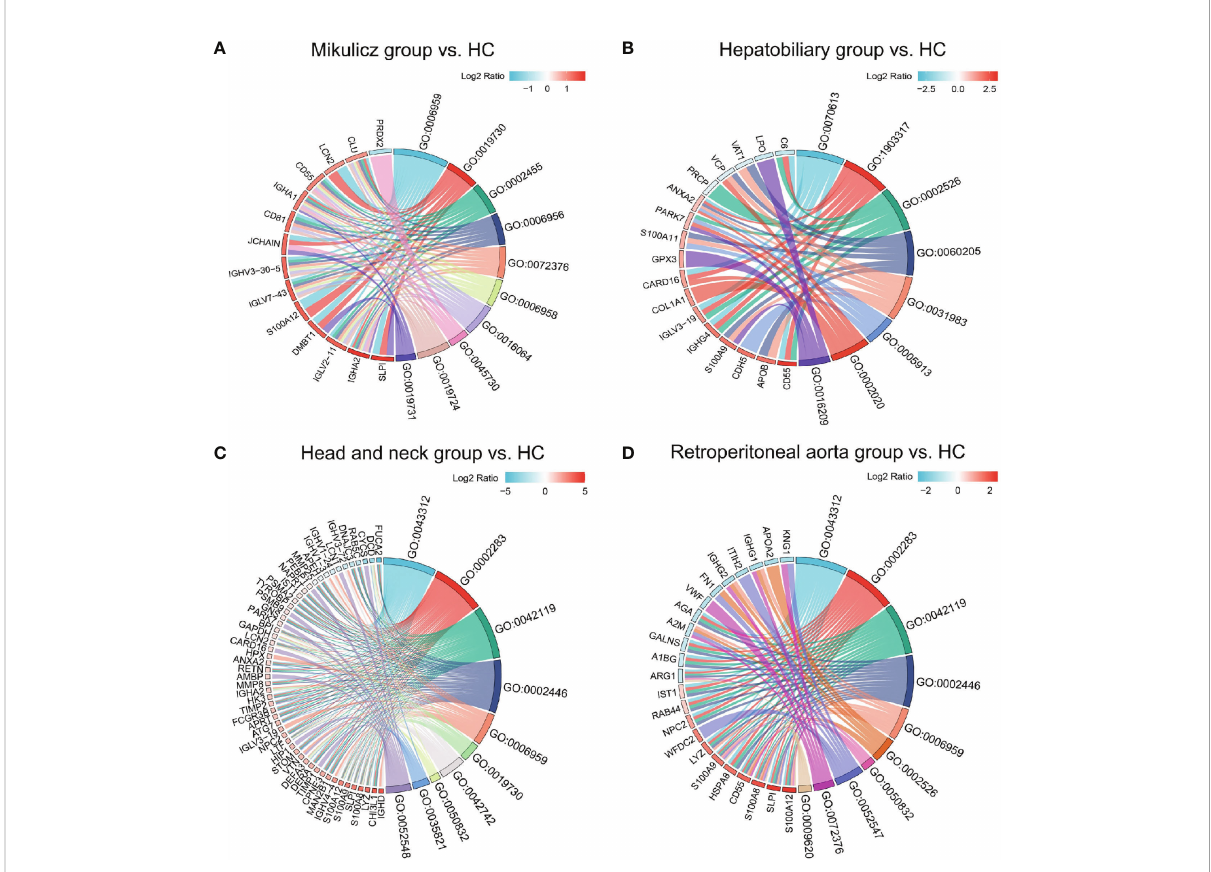
FIGURE 5 Chordal diagram of top ten GO categories in comparisons of IgG4-RD with four subgroups vs. HC. Chordal diagram of top ten GO categories in comparisons of (A) Mikulicz group vs. HC, (B) Hepatobiliary group vs. HC, (C) Head and neck group vs. HC, and (D) Retroperitoneal aorta group vs. HC in saliva. The left half part is the gene color block and different color represents the corresponding gene Log2 Ratio values, the right half is the GO category color block, and the size of the color block represents the corresponding